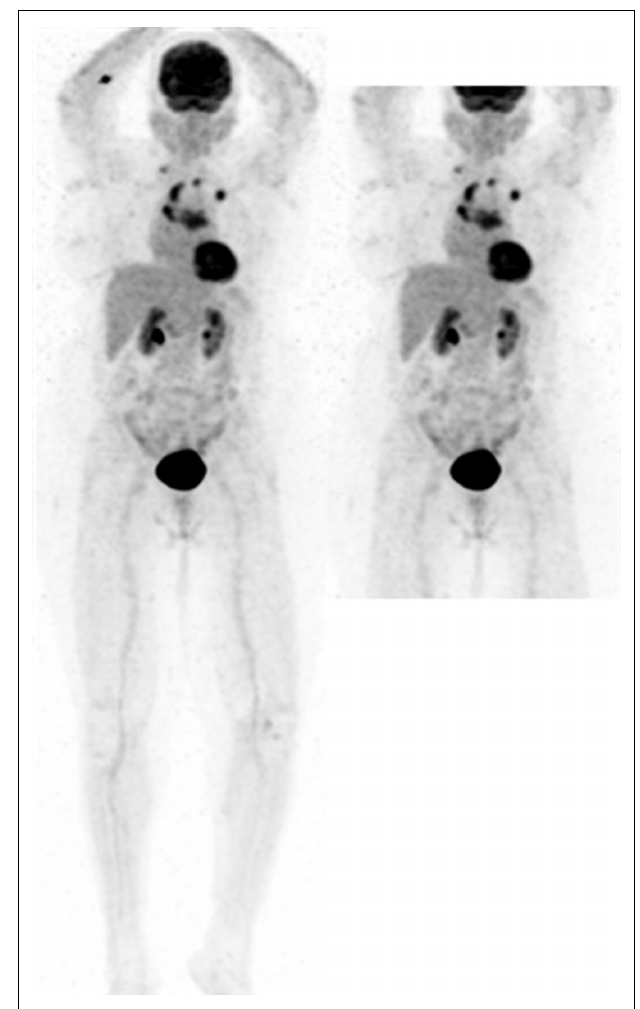
FIGURE 2 | MIP PET image of an 83-year-old female with metastatic disease from an unknown primary. Patient was injected in the right antecubital fossa (RAC) with dose extravasation (SUVmax 7) outside the LWB FOV